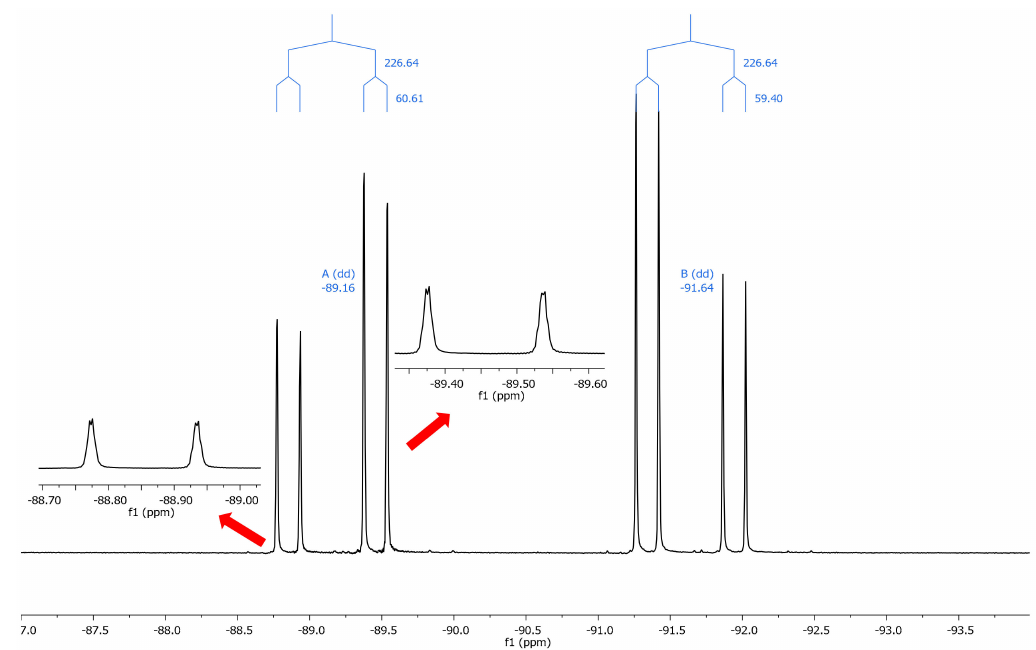
Figure 2. 19 F-NMR spectrum of 13 in CDCl 3 at 300 K with signals at − 89.16 ppm (ddd, 2 J F = 226.6, 2 J 6 J 2 J − 91.64 (dd, 2 J H = 60.6, H = 1.4), and F = 226.6, H = 59.4); the red arrows correspond to the amplification of the left and right side of the signal at − 89.16 ppm.